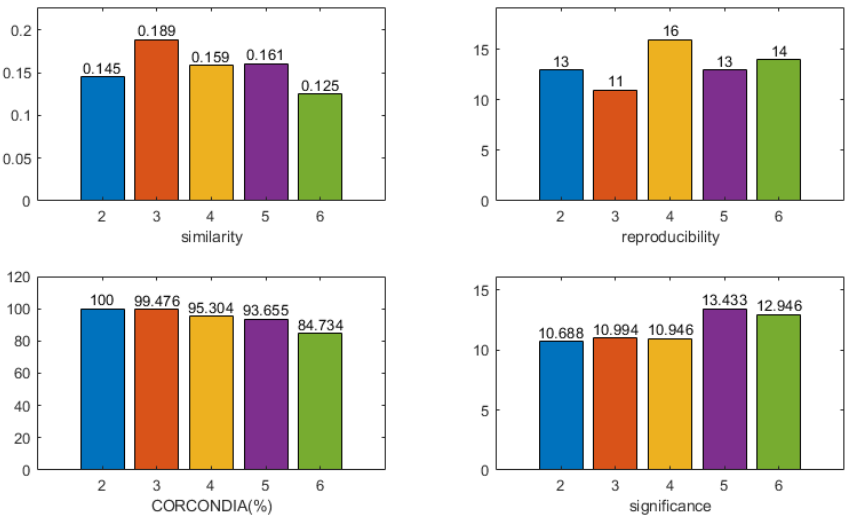
Figure 6. The four indicators of the CMTF model of different numbers of components for subject 13 were calculated. According to the model selection guidelines, a component number of 2 was chosen to analyze the CMTF results for this subject.